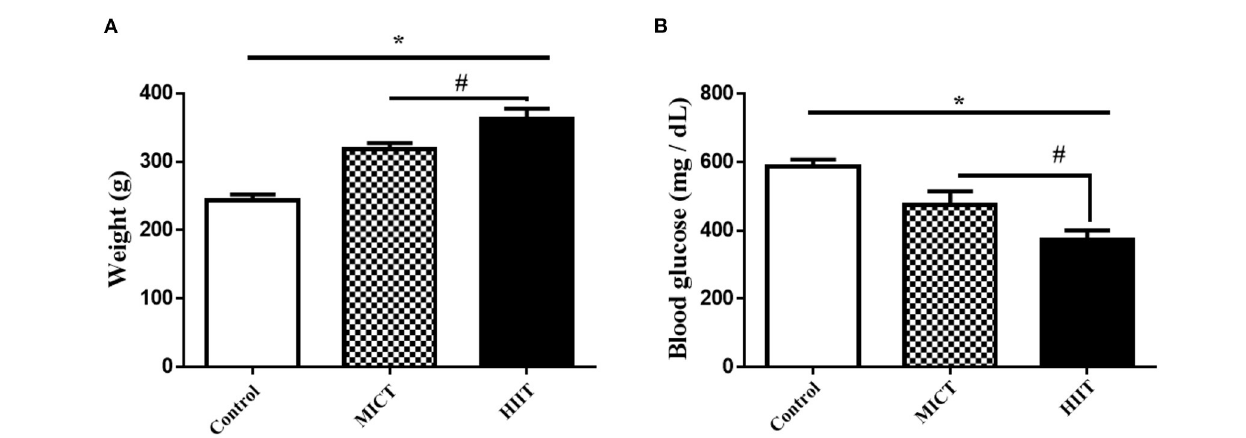
FIGURE 1 | Body mass and fasting blood glucose concentrations in the three experimental groups. (A) Body mass (B) Blood glucose. Data are presented as means ± standard error of the mean (SEMs). *Significant differences between control and intervention groups, # Significant differences between MICT and HIIT. MICT, moderate-intensity continuous training; HIIT, high-intensity interval training. Rats ( n = 6 per group) were trained for 5 weeks.